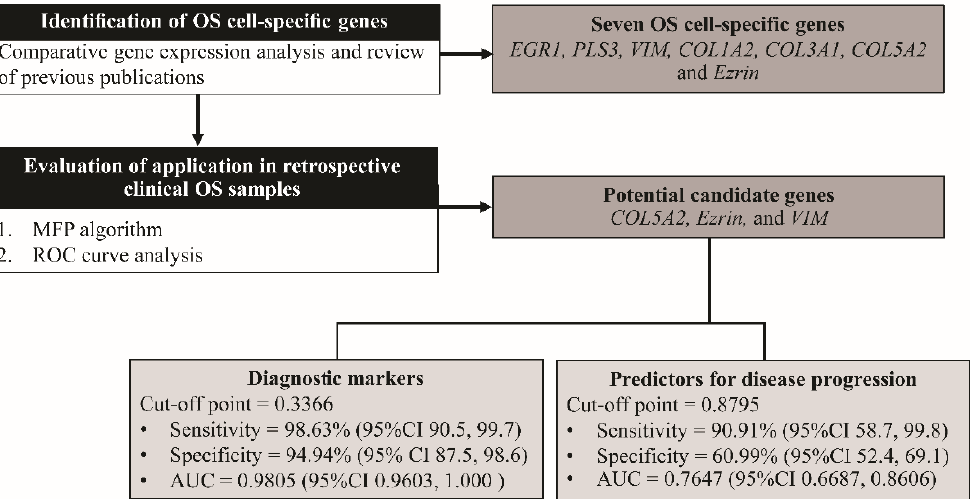
Figure 1. Overview of the study and workflow of methods. OS, osteosarcoma; COL1A2 , collagen type-I alpha-2 chain; PLS3 , plastin-3; COL5A2 , collagen type-V alpha-2 chain; COL3A1 , collagen type-III alpha-1 chain; EGR1 , early growth response protein 1; VIM , vimentin; MFP; multivariable fractional polynomial, ROC; receiver operating characteristic curve; AUC, area under the ROC curve; CI, confidence interval.